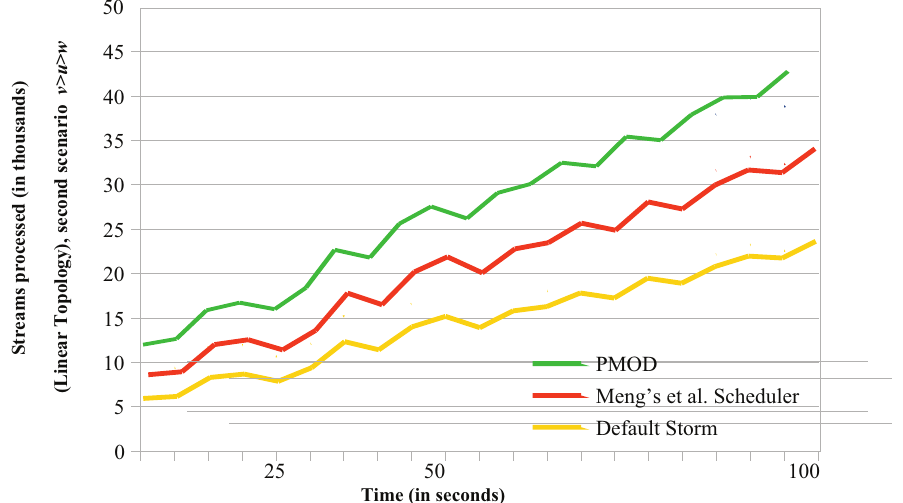
Figure 7. Throughput comparisons with a linear topology for the second scenario: ( v > u > w )